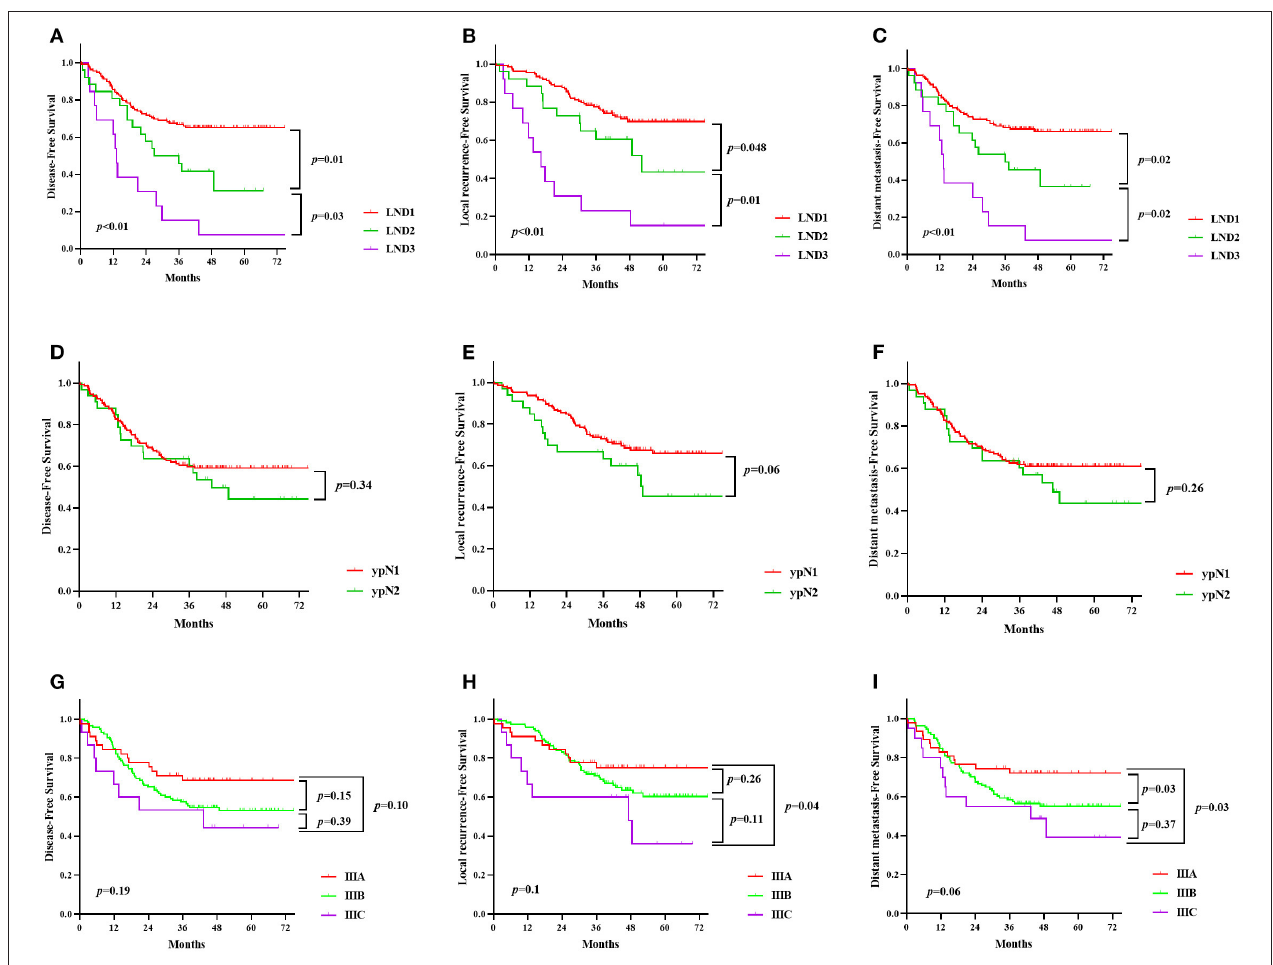
FIGURE 1 | Kaplan-Meier survival curve according to lymph node distribution (LND) (A–C) , the ypN stage (D–F) and ypTNM stage (G–I) . (A,D,G) , disease-free survival; (B,E,H) , local recurrence-free survival; (C,F,I) , distant metastasis-free